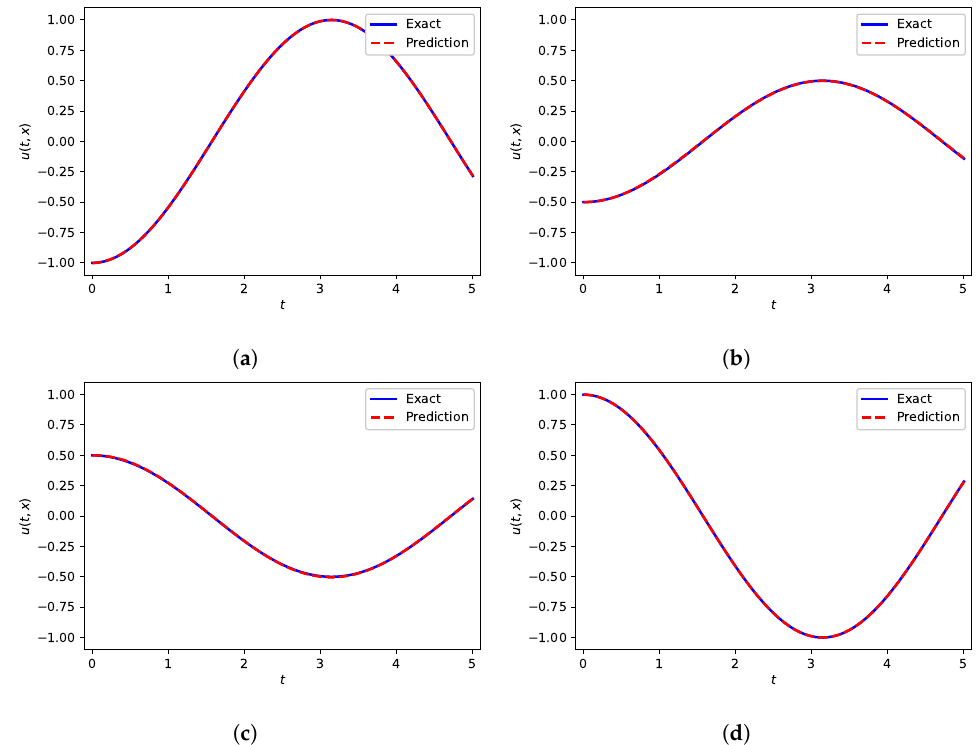
Figure 10. Comparison of predicted solution and exact solution of Equation (34) corresponding to different x . ( a ) x = − 1; ( b ) x = − 0.5; ( c ) x = 0.5; ( d ) x =